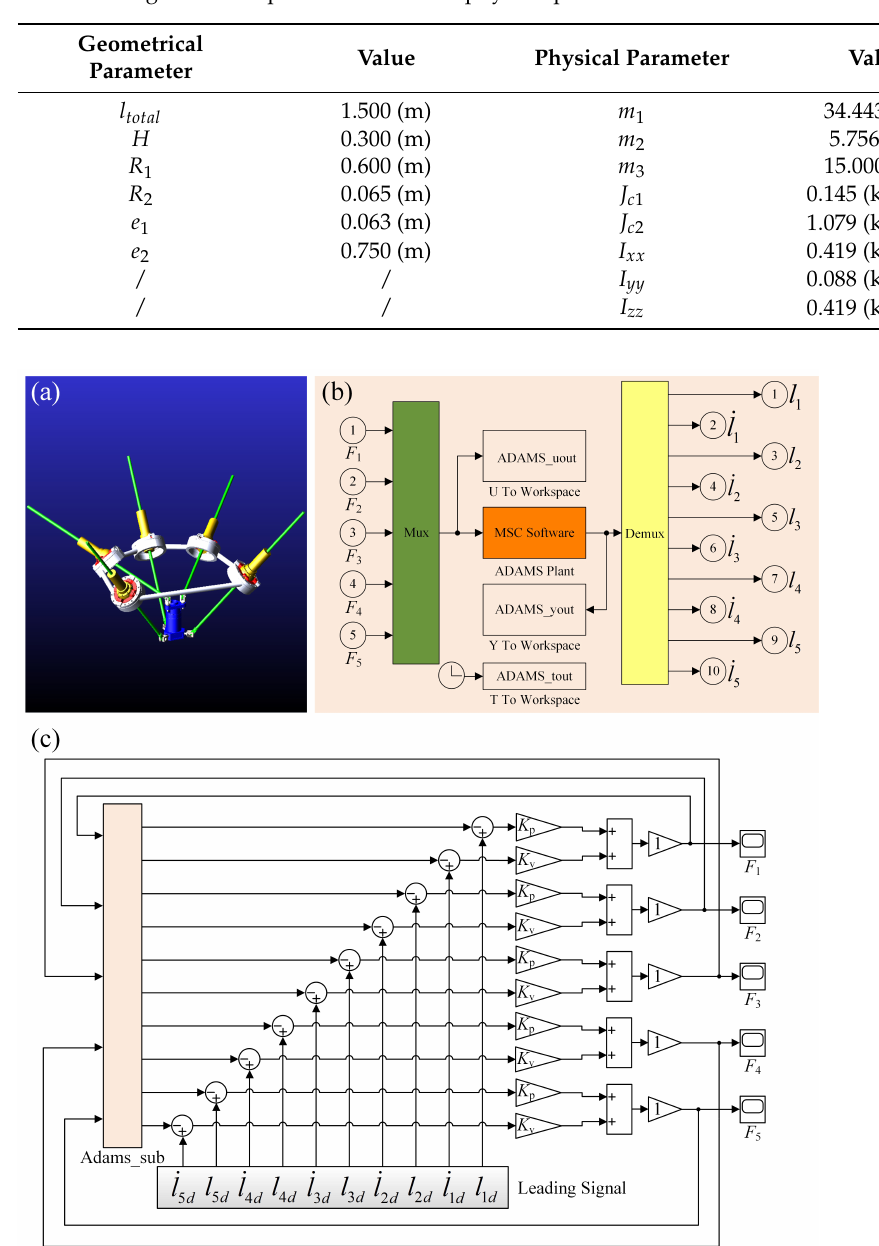
Figure 3. Diagram of co-simulation by using MSC ADAMS and MATLAB/Simulink. ( a ) virtual proto- type of 5-DoF spatial PM in ADAMS. ( b ) 5-DoF spatial PM as an ADAMS plant in MATLAB/Simulink. ( c ) Block diagram of co-simulation with PD control in Simulink, where ADAMS_sub represents the ADAMS plant, and K p , K v represent the position gain and velocity gain,